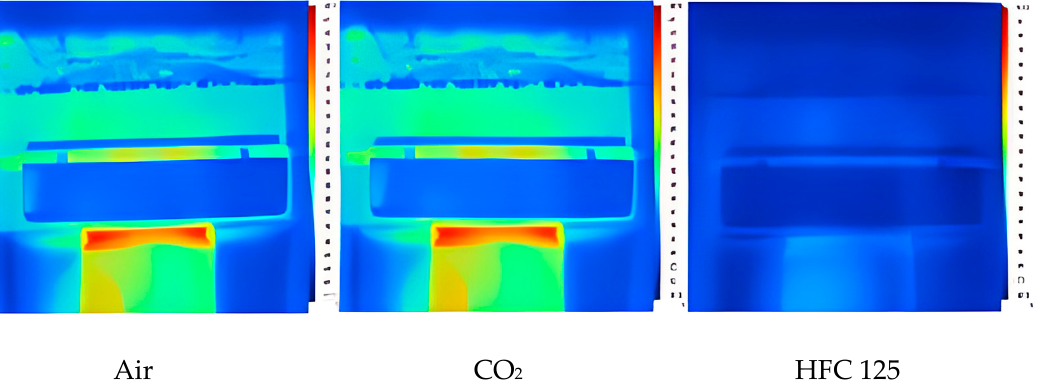
Figure 7. Thermal infrared images of skylights after testing with air, CO 2 and HFC-125 [20]. For CO 2 gas to reach temperatures below the ambient, an elevated pressure may be recommended which, however, would require thick glass with consequently lowered transmissivity. In response to this, this led to the choice of HFC-125 refrigerant for skylight construction. Other mixed refrigerants such as NH 3 (strong pungent smell), HFC-32, HFC- 134A, HFC-143A, and SF 6 were also studied or considered, but their flammability and other safety reasons preclude their usage. Due to the recent phase-out of HFC-125 [61], R-32, R-410a, R454b, and R449A are likely to be considered for the further scale-up of the skylight window prototype at the ÅA-PST